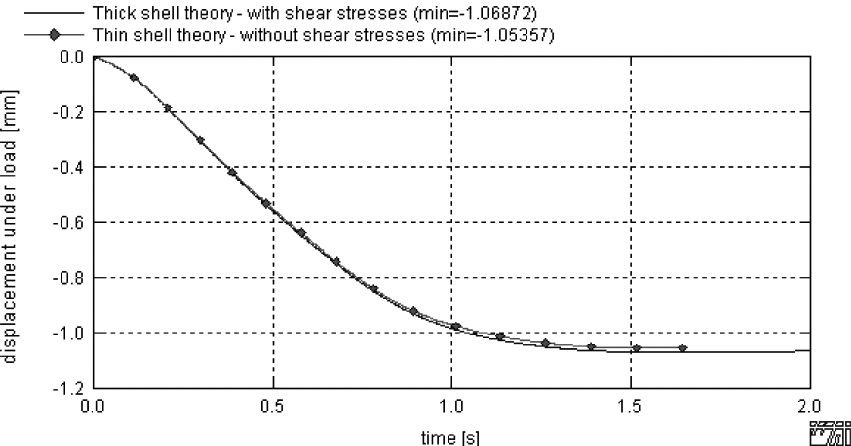
Fig. 8. Displacement time histories (displacement under load) with reduced